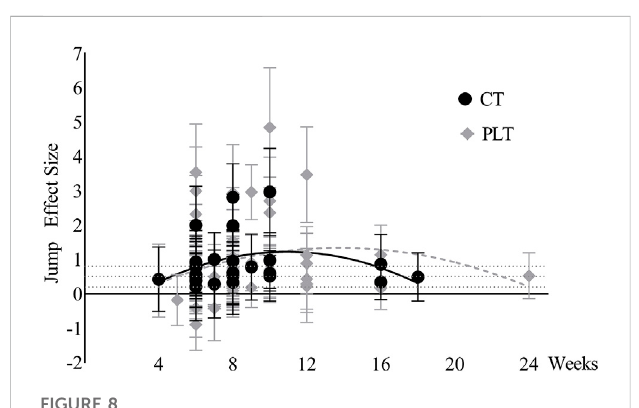
FIGURE 9 Sprint ability changes over time (CT = complex training, PLT = plyometric